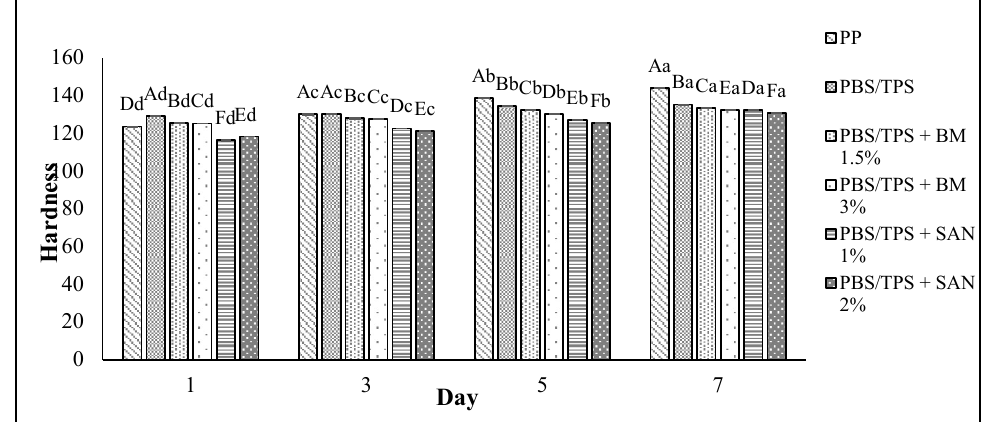
Figure 8. The hardness values of chicken breast fillets stored in PP container and PBS/TPS film laminated tray during storage at 4 °C for seven days. Note: PP: polypropylene microwavable container (control); PBS/TPS: PBS/TPS film (untreated); PBS/TPS + BM 1.5%: PBS/TPS film + 1.5% Biomaster silver; PBS/TPS + BM 3%: PBS/TPS film + 3% Biomaster silver; PBS/TPS + SAN 1%: PBS/TPS film + 1% SANAFOR; PBS/TPS + SAN 2%: PBS/TPS film + 2% SANAFOR. Error bars indicate standard deviation (n = 3). The different A–F capital letters are significantly different ( p < 0.05) among treatment for each day. The different a–d lowercase letters are significantly different ( p < 0.05) among storage day for each sample.